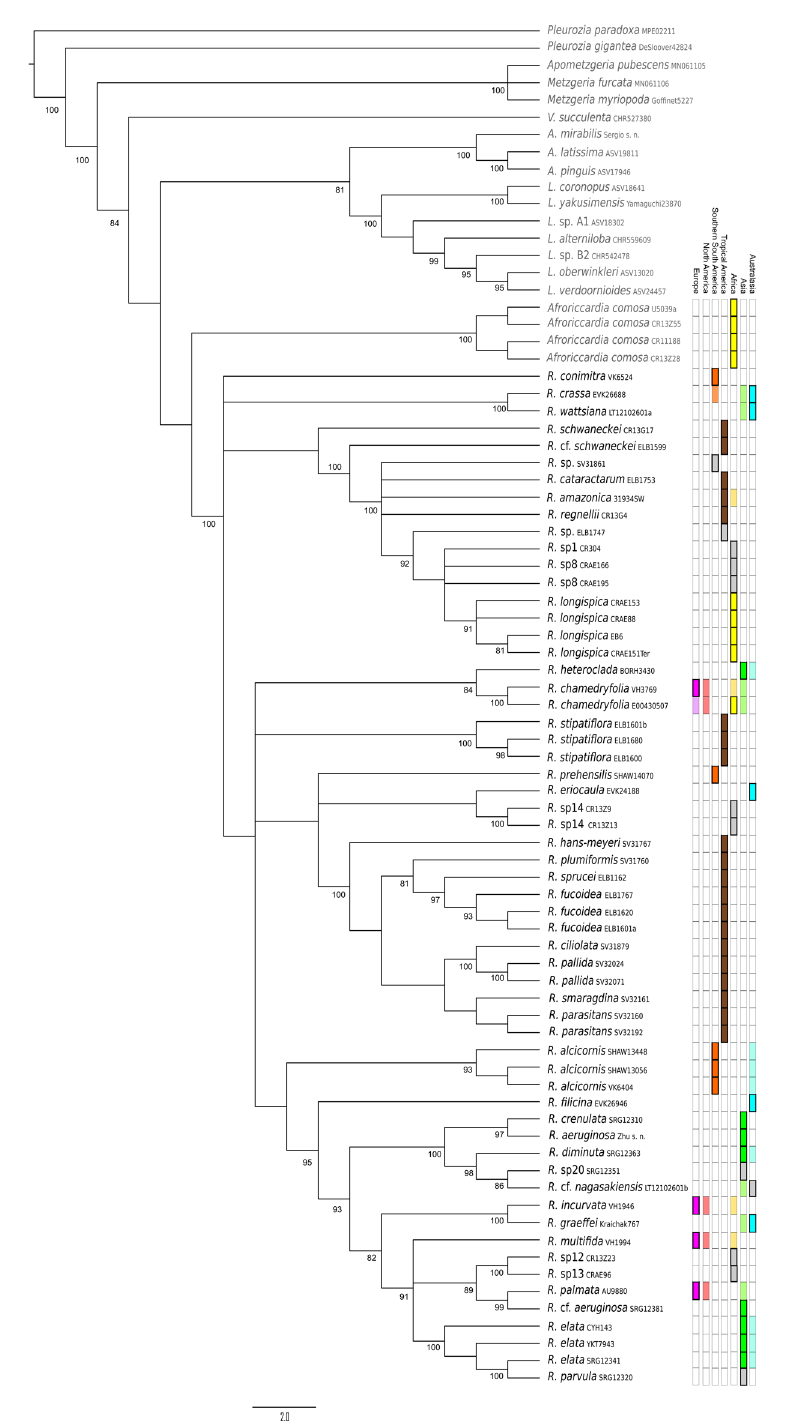
Fig. 2. This topology shows the result of the maximum parsimony ratchet. Bootstrap proportions above 80% are indicated under each node. Species names appear in italics, followed by the corresponding voucher number. Outgroup labels appear in light grey. The geographical origin of each Riccardia or Afroriccardia sample is marked by bold rectangles. The continental/geographical repartition of each species according to the literature is indicated with rectangles coloured by continents: Europe (purple), North America (red), southern South America (orange), tropical America (brown), Africa (yellow), Asia (green) and Australasia (blue). A grey rectangle indicates new continental records for the